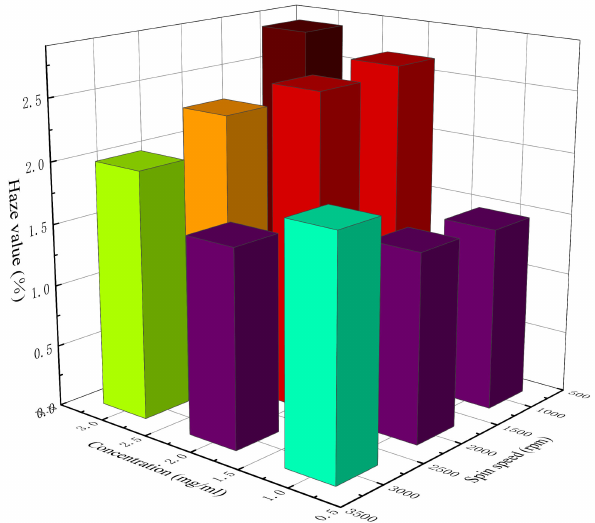
Figure 6. The 3D histogram of the variation in haze value with concentration and spin